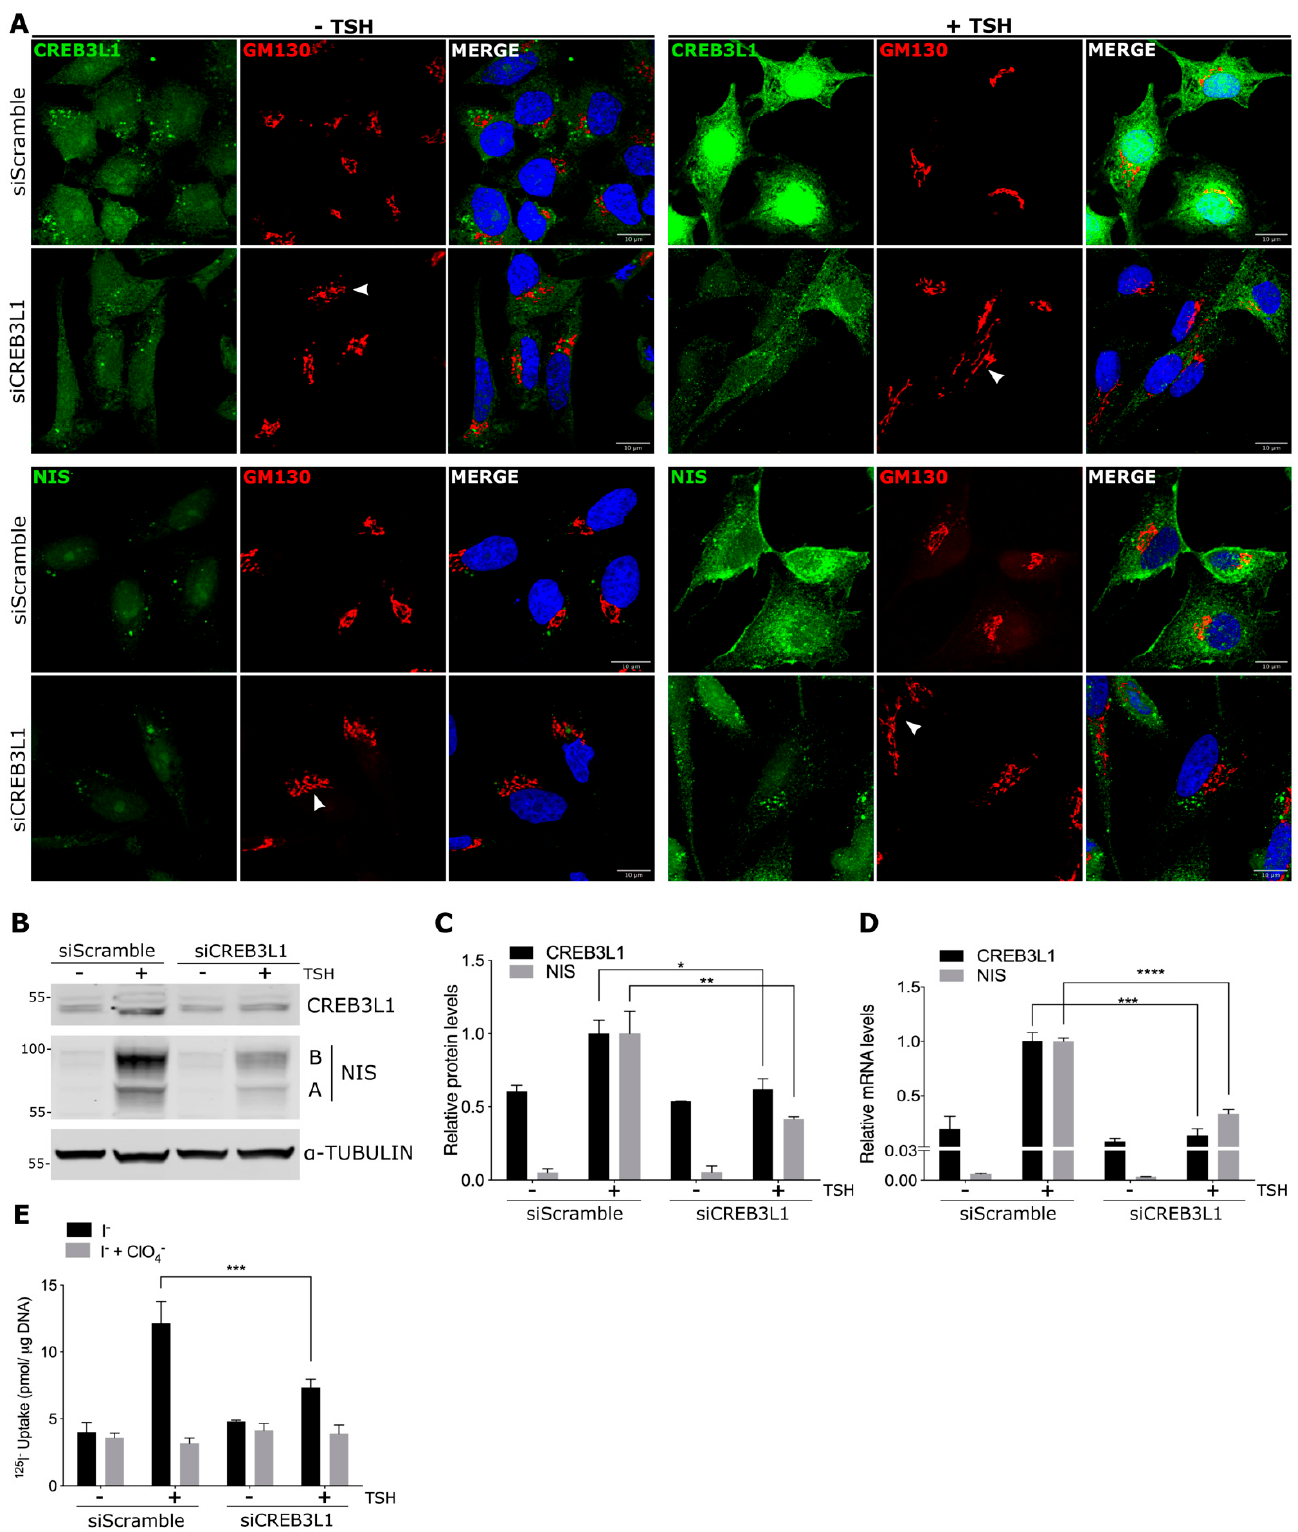
Figure 4. CREB3L1 regulates NIS expression upon TSH stimulation: FRTL-5 cells were transfected with either siCREB3L1 or siScramble for the control condition. Transfection was performed under the growth condition for 24 h. Then, the cells were incubated under the starvation condition for 72 h ( − TSH) before TSH stimulation for 16 h (+TSH, stimulated condition). ( A ) Confocal immunofluo- rescence analysis with antibodies against CREB3L1 or NIS (green) and GM130 (red). Arrowheads in the GM130 panels indicate disruption of the Golgi phenotype. The nuclei were labeled with